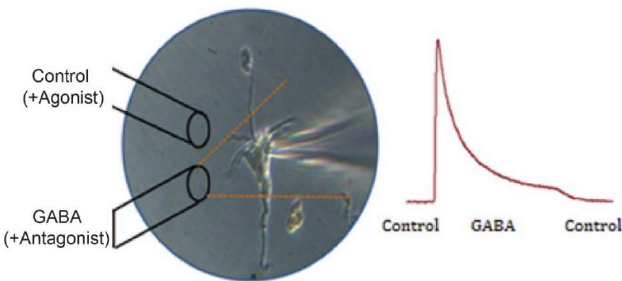
Figure 1. Application of solutions using capillaries. The application of solutions was controlled using solenoid valves; on the right of the photo, there is a representative trace of the current generated by the GABA application.